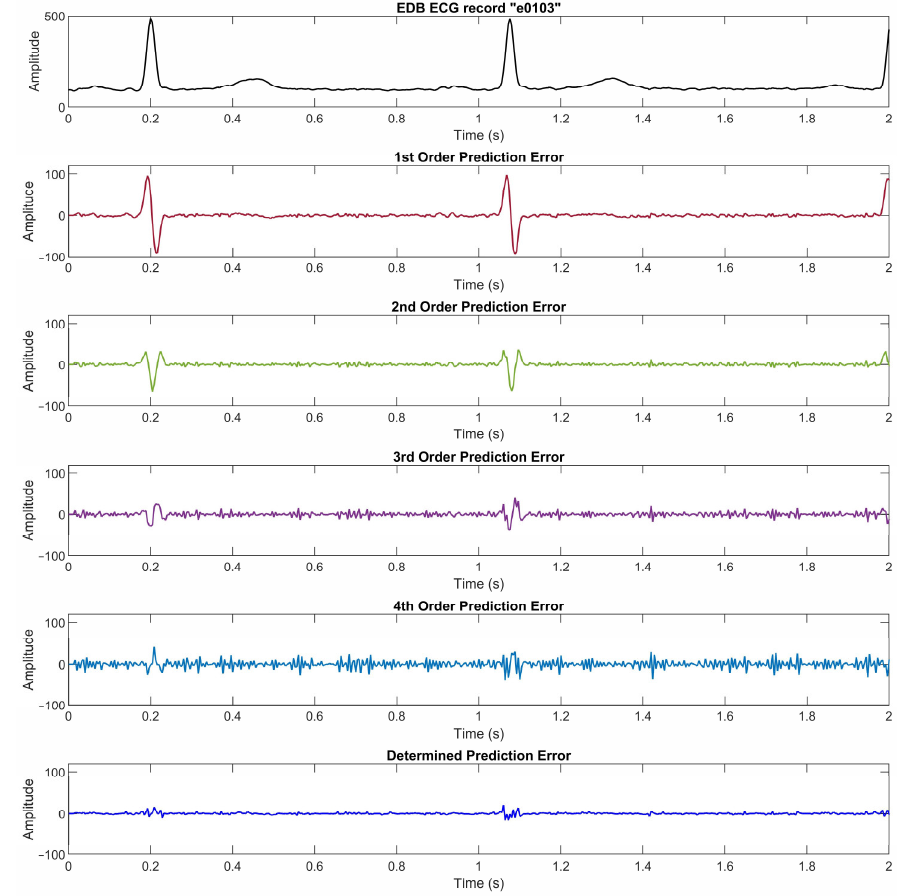
Figure 10. The ECG signal, prediction errors for linear prediction orders 1, 2, 3, and 4, and the determined prediction error of EDB record “e0103”. To convert the amplitude to millivolts, divide the value by 200.